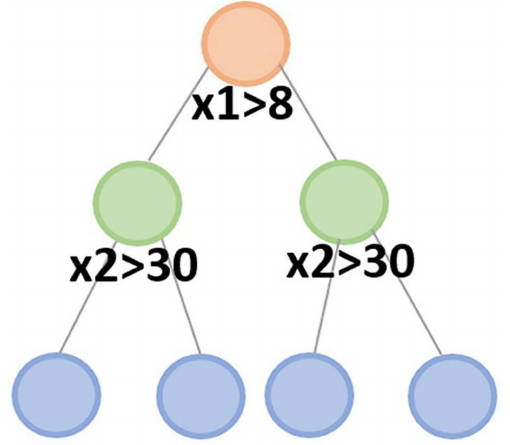
Figure 2. CatBoost decision tree for the regression